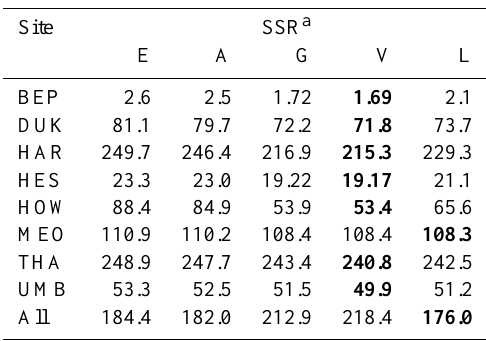
Table 3. Summed squared residuals of nonlinear model fits